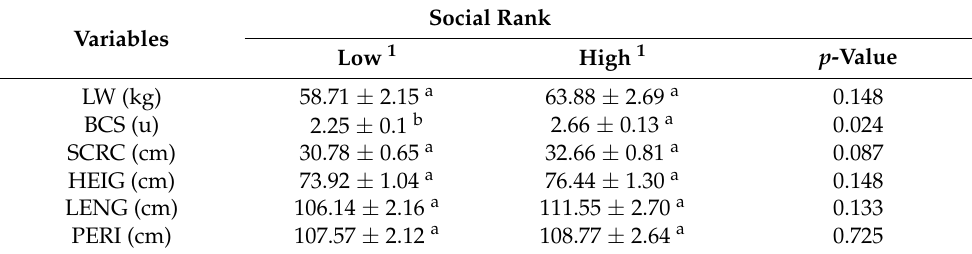
Table 2. Least square means ± standard error for live weight (LW), body condition score (BCS), scrotal circumference (SCRC), height at the withers (HEIG), length (LENG), and thoracic perimeter (PERI), according to either low ( n = 15) or high ( n = 9) social rank in Dorper rams ( n = 24) in northern Mexico (25 ◦ N).